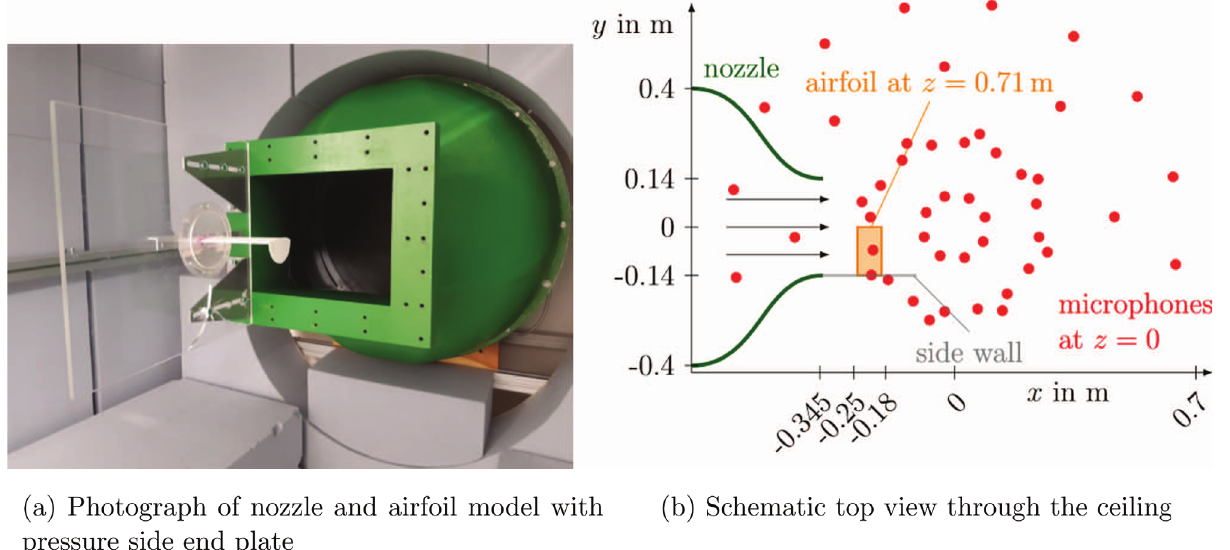
Figure 2. Acoustical measurement set up in aeroacoustic wind tunnel at